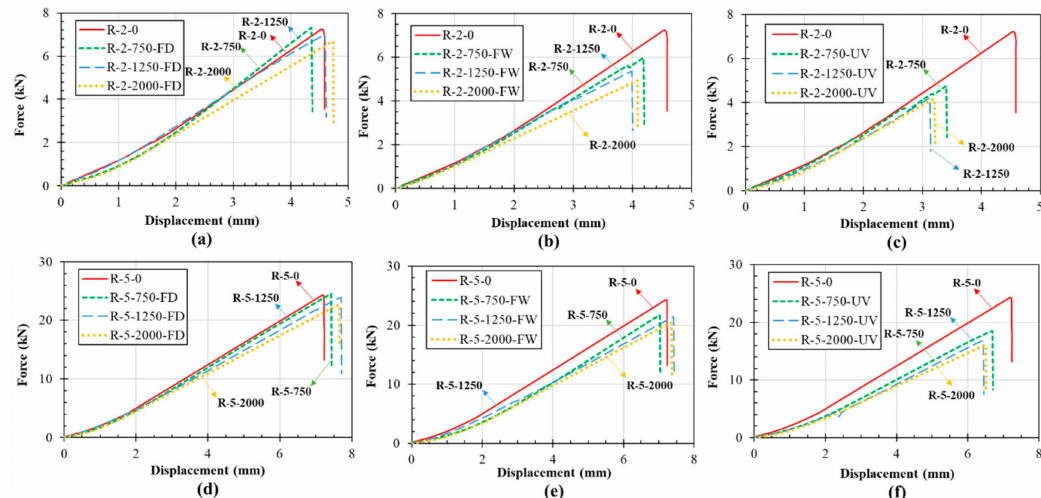
Figure 14. Load-deflection curve of RL: ( a ) 2-mm laminate exposed to FD, ( b ) 2-mm laminate exposed to FW and ( c ) 2-mm laminate exposed to UV, ( d ) 5-mm laminate exposed to FD, ( e ) 5-mm laminate exposed to FW and ( f ) 5-mm laminate exposed to